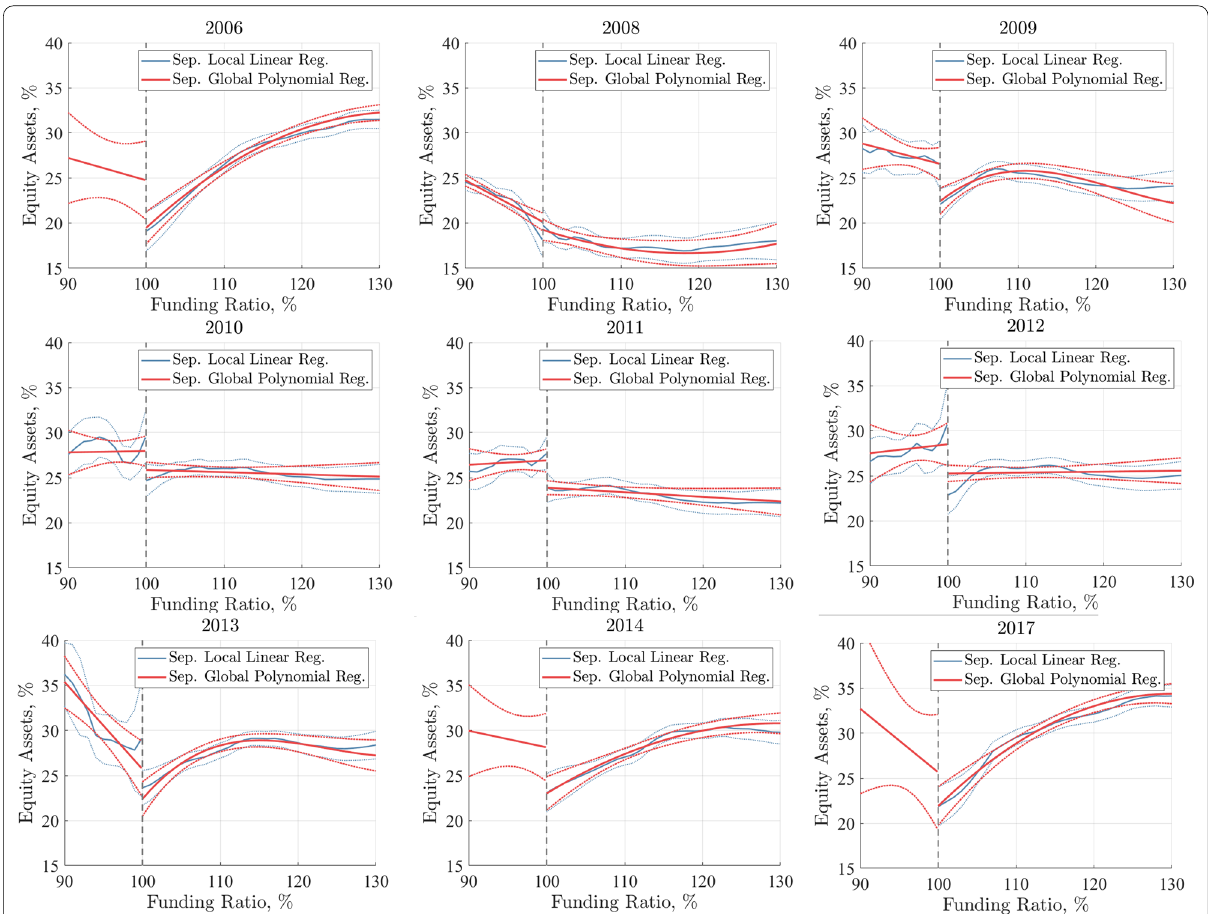
Fig. 11 Average Share of Equity Assets - Separate Local Linear and Global Polynomial Regression. Figures show weighted average share of assets invested in equities (y-axis), conditional on the funding ratio of the funds (x-axis). Estimates considering as sample only funds in a shortfall (below 100%), and sufficiently funded funds (equal and above 100%), respectively. Solid blue line shows averages estimated by a local linear regression using a tricube kernel with varying bandwidths, considering the closest 20% of observations. Solid red line shows averages from global polynomial regressions, with different numbers of polynomial terms to the left and right of 100%. Dotted lines show 95% confidence bands from bootstrapped standard errors (500 iterations). To the right of 100% the average equity share increases concavely in almost all years. The average equity share for funds in a shortfall (left) is discontinuously higher than the share invested by funded funds (right). The sample includes only private and public funds without state guarantees, and only includes funds with a funding ratio between 81.5 and 152.3% (0.5th–95th percentile range). Local linear regression estimates are not shown where the number of observations for regression does not exceed 10. Years, 2007, 2016, and 2017 in the main